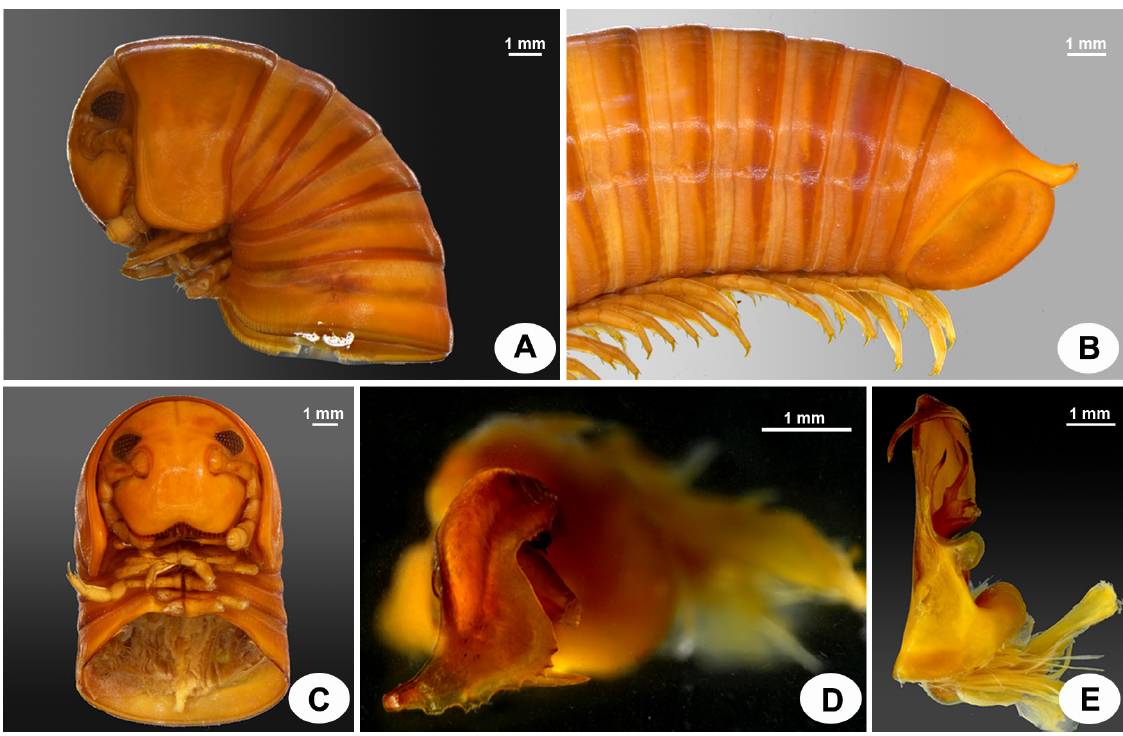
Fig. 1. Alienostreptus alienus (Attems, 1936), syntype (NHMW 2556). A . Head and anterior body rings, lateral view. B . Ultimate body rings, lateral view. C . Head and first body rings, ventral view. D . Right gonopod coxa, apical view. E . Right gonopod (distal part of telopodite broken), posterior